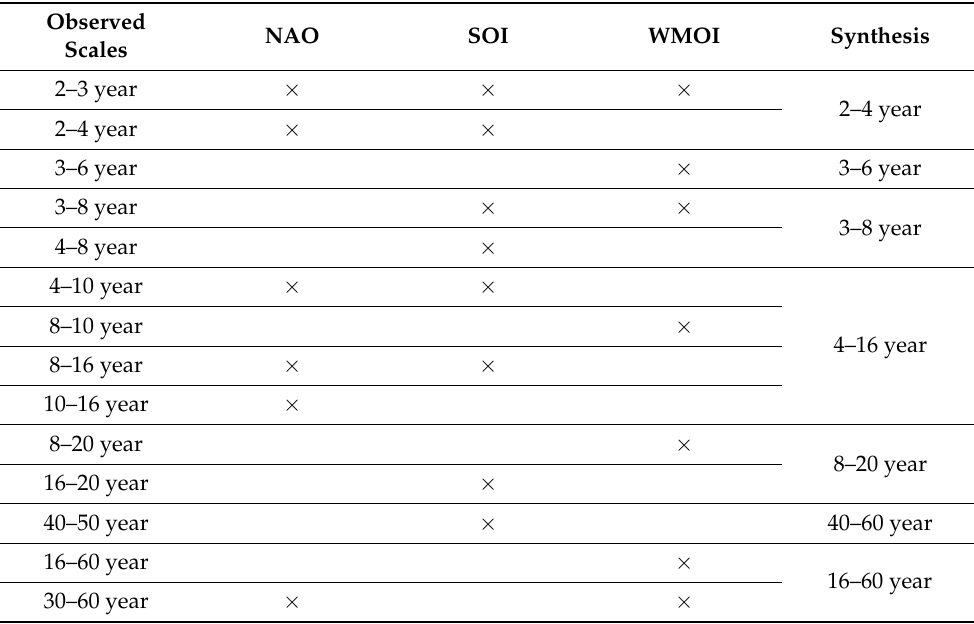
Table 4. Global summary of changes identified by continuous wavelet analysis in the main climate